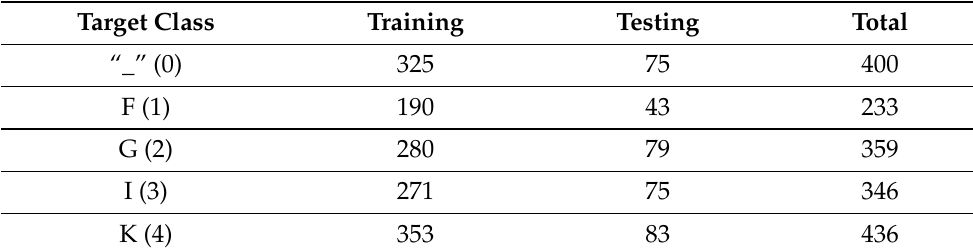
Table 8. Number of samples for training and test subset.